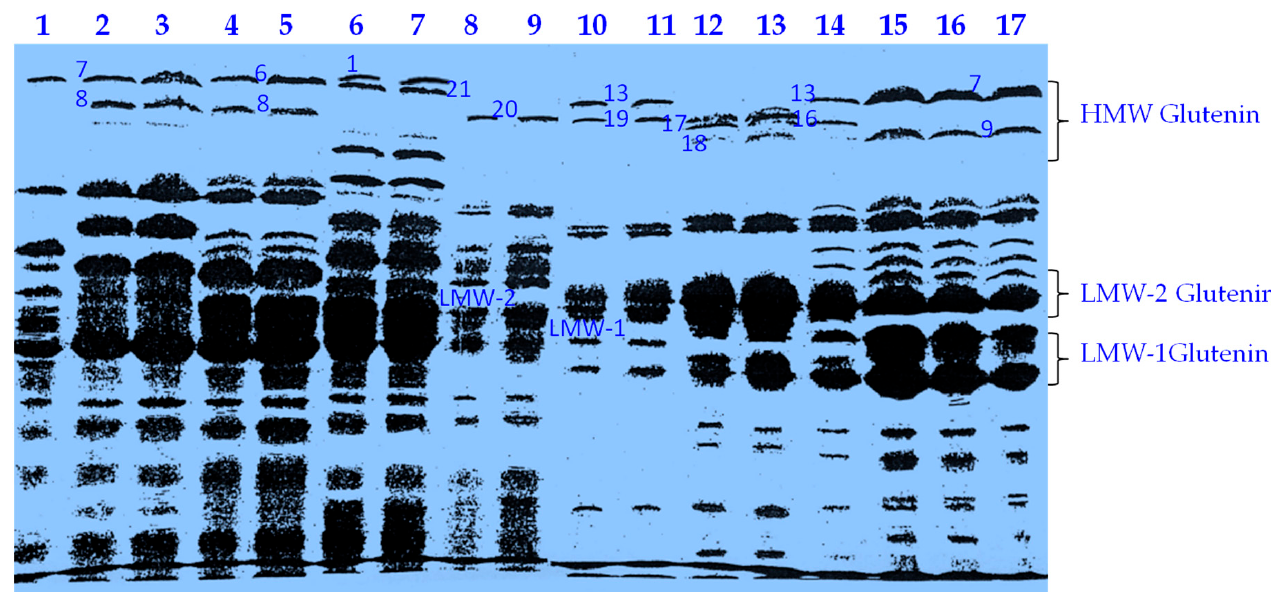
Figure 1. A sample SDS-PAGE output with some HMWGSs and LMWGSs found in studied tetraploid durum wheat genotypes. Lanes from 1 to 17 are genotypes 1, 3, 4, 7, 10, 13, 18, 22, 23, 27, 29, 32, 36, 42, 47, 49, and 51, respectively. Table 2. Mean values for protein content (%) and SDS sedimentation volumes for HMWGS